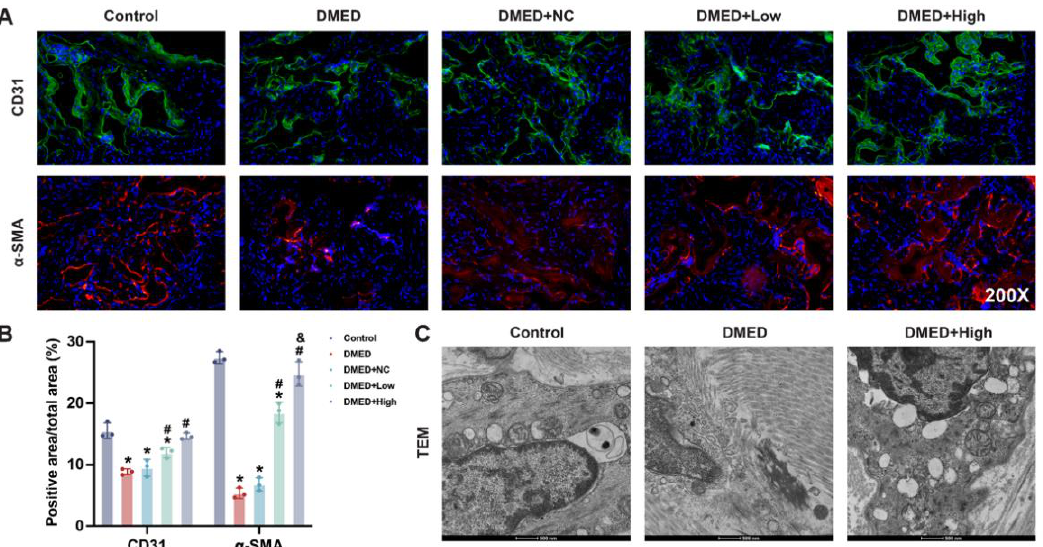
Figure 4. Effect of GPX4-LV injection on endothelial and smooth muscle content in DMED rats. Representative results of immunofluorescence for α -SMA ( A ) and CD31 ( B ) (200×). ( C ) Representative results of transmission electron microscopy in the three groups. * p < 0.05 compared with the control group. # p < 0.05 compared with the DMED group. & p < 0.05 compared with the DMED + low group.